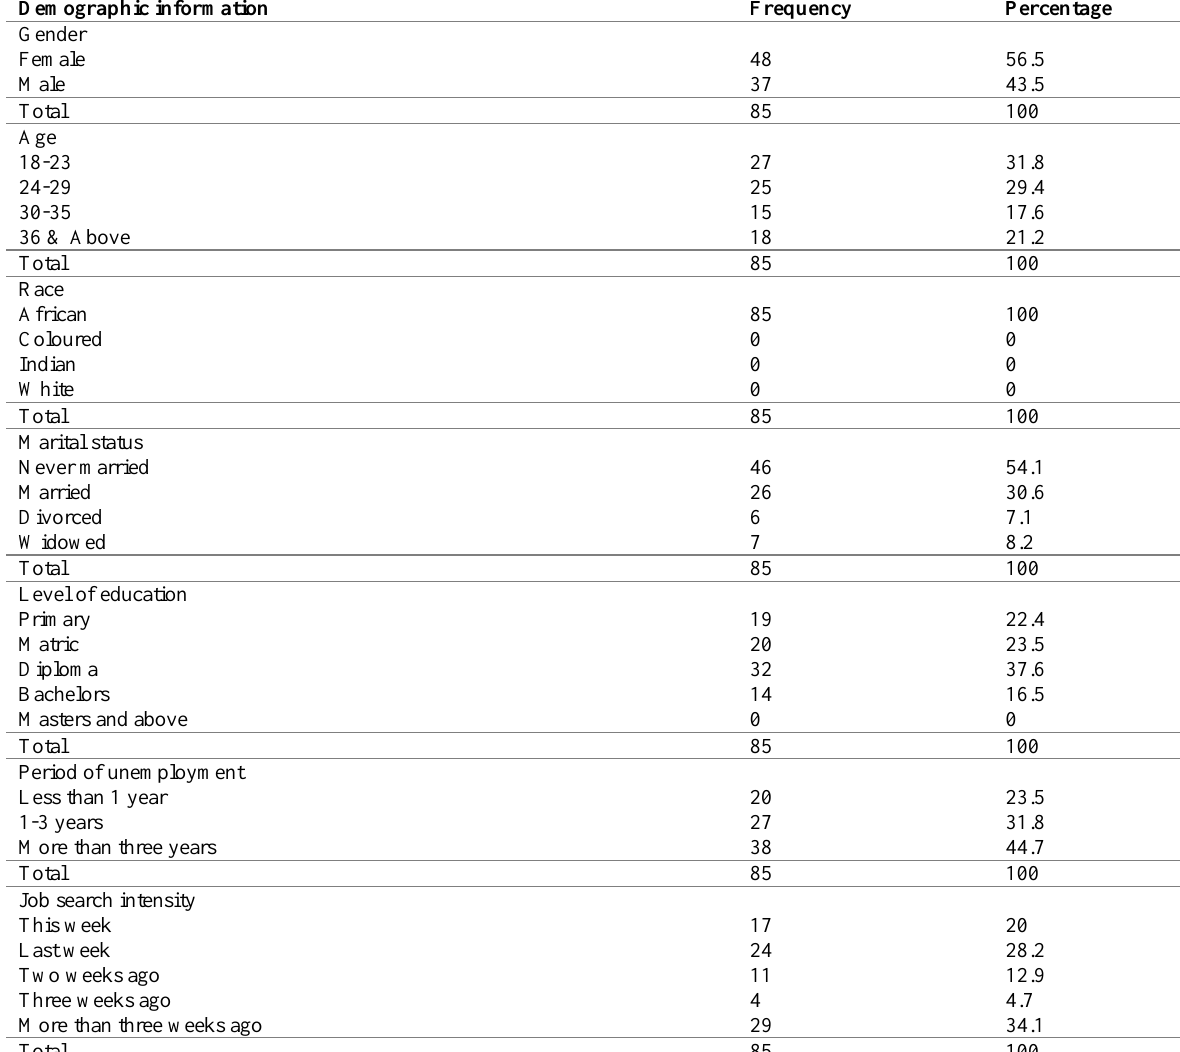
Table 1: Demographic information of the